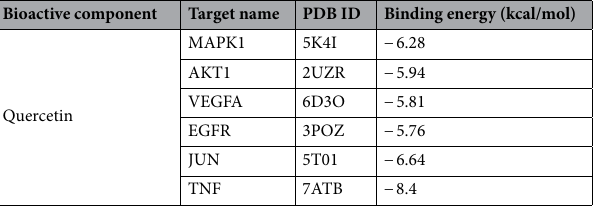
Table 1. Binding energy of quercetin with MAPK1, AKT1, VEGFA, EGFR, JUN, and TNF.